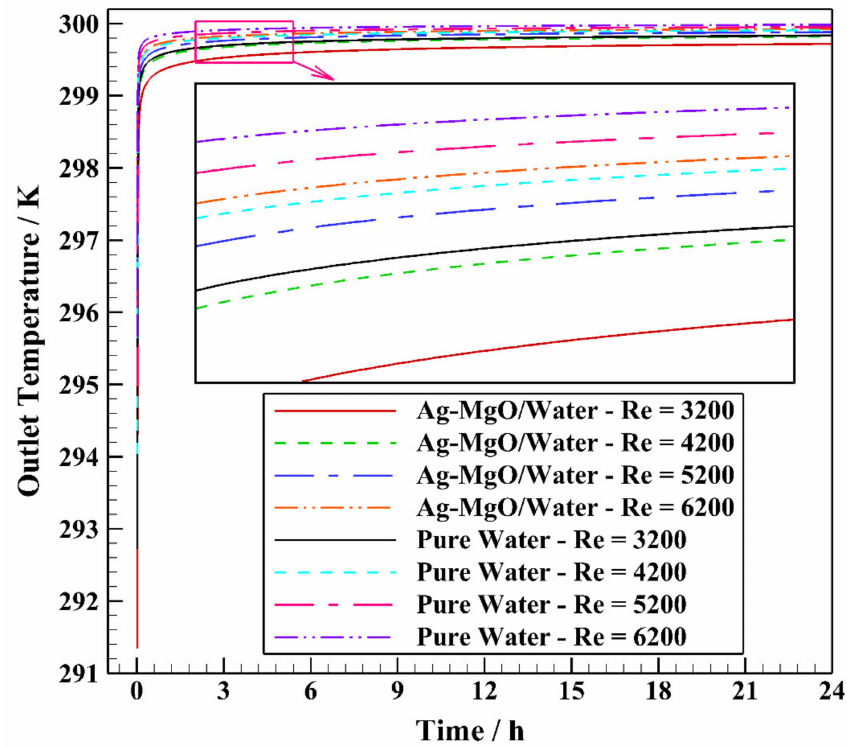
Figure 16. The variation of the outlet temperature with operating time using Ag-MgO/water hybrid nanofluid with different Reynolds numbers at φ =